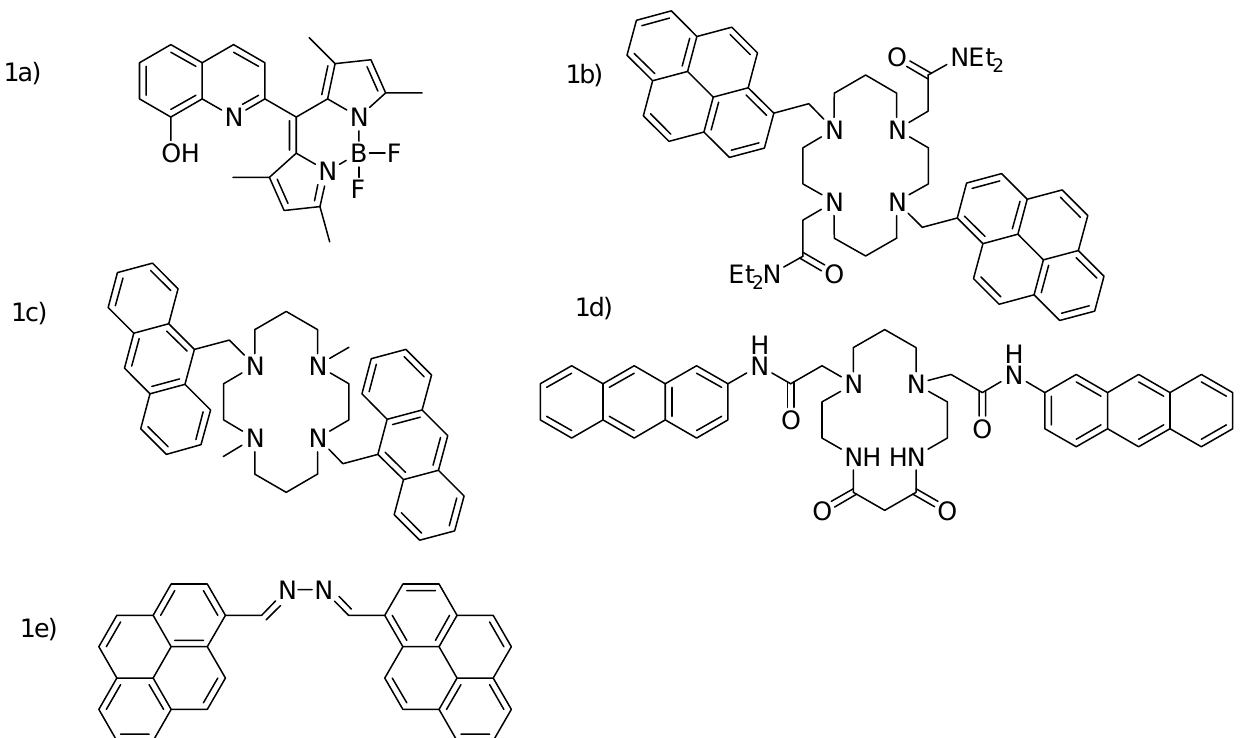
Figure 1. Chemical structures of some mercury